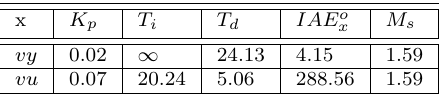
Table 5: Shows the reference controllers which mini- mizes the indices IAE vy and IAE vu , i.e. opti- mal output and input disturbance (ideal) PID controllers as in Eq. (36), i.o., given a pre- scribed M s = 1 . 59.